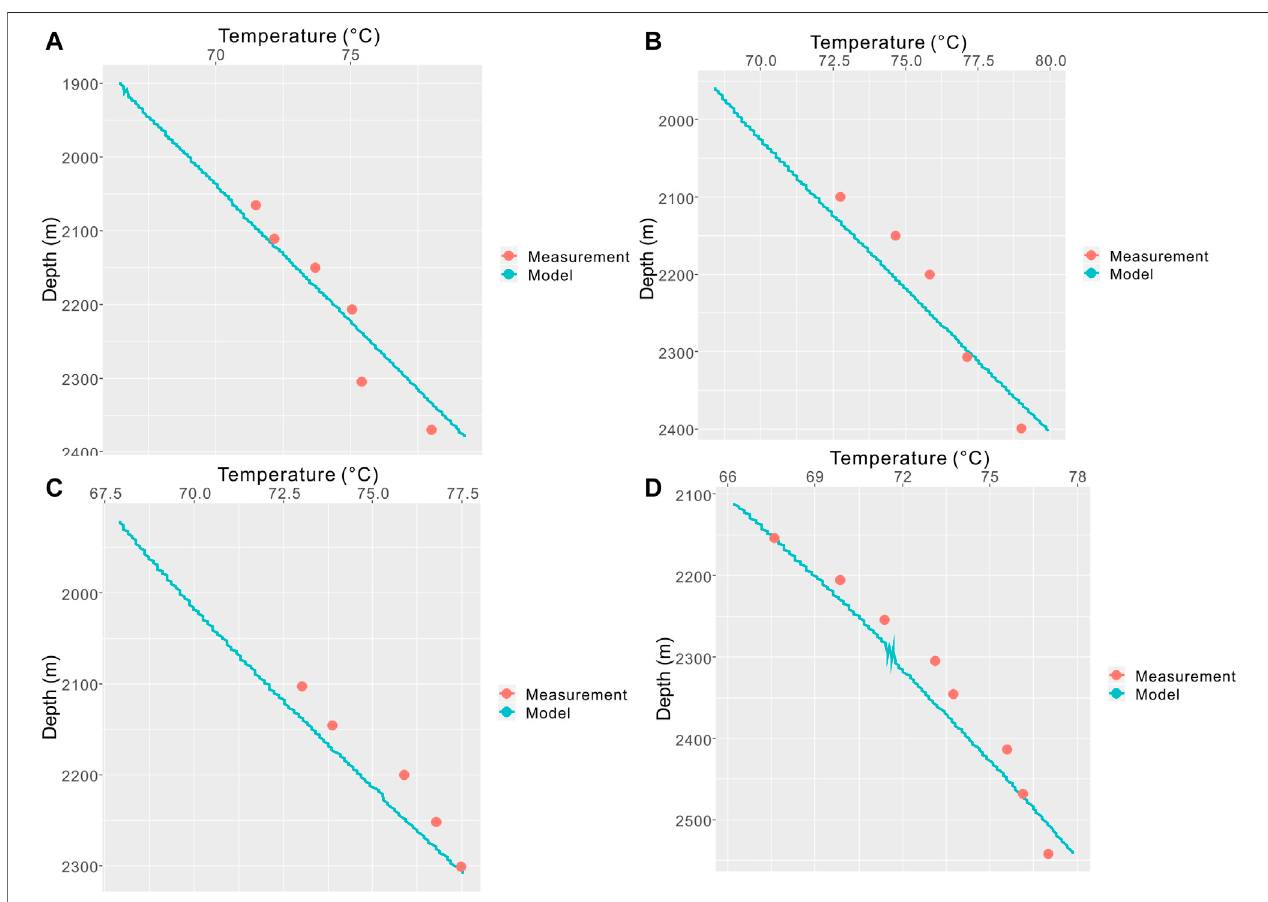
FIGURE 8 | Comparison of simulated temperature data with the measured temperature data at different wells. The well locations are shown in Figure 2 .